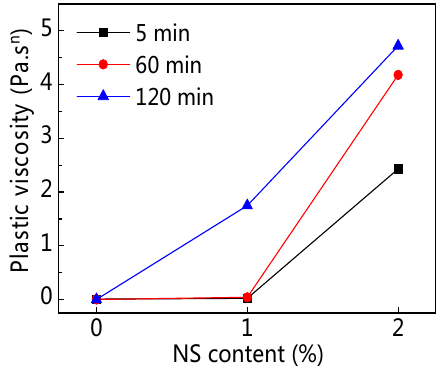
Figure 10. Influence of NS on plastic viscosity ( K ).